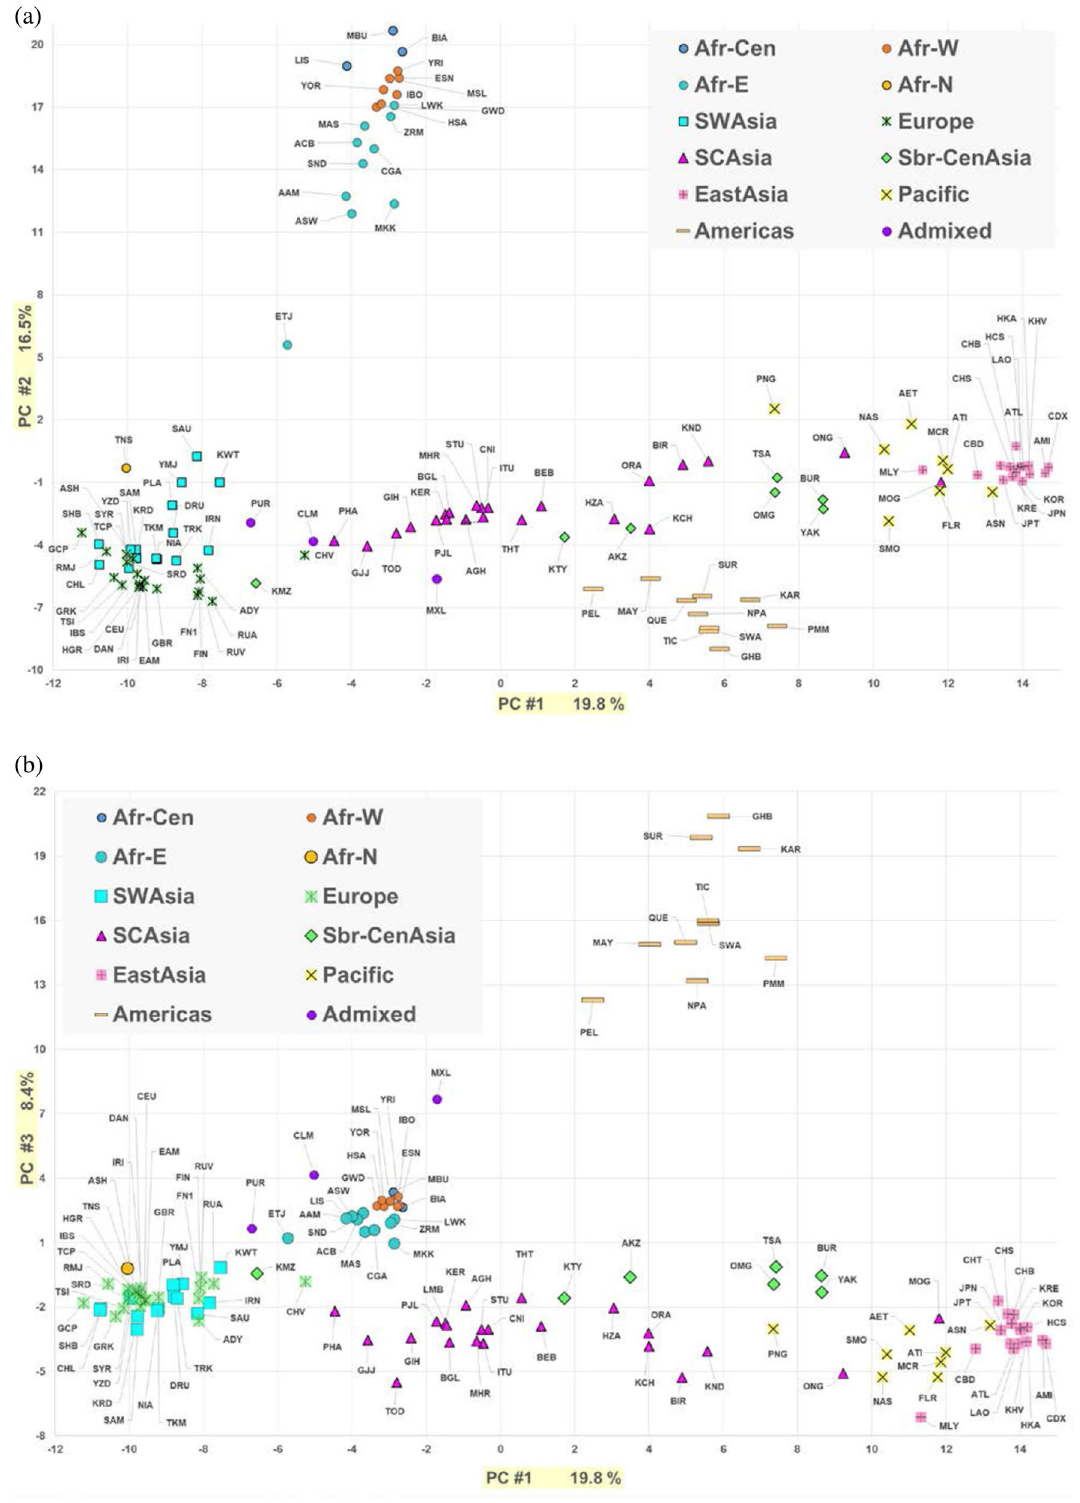
Figure 3. PCA results for 122 populations. ( a ) PC1 by PC2. ( b ) PC1 by